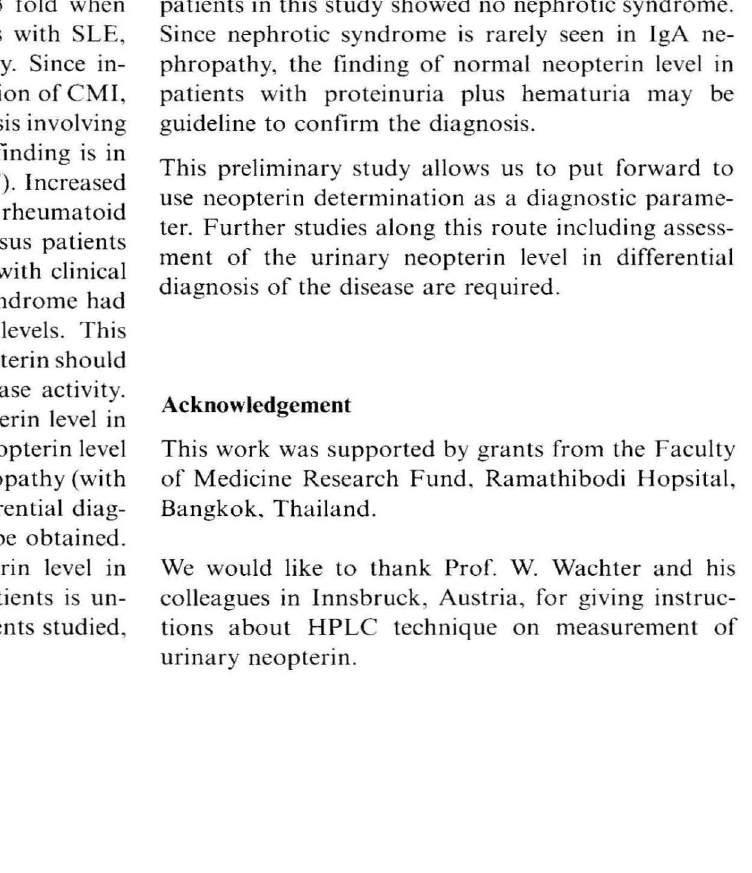
Figure 2. Urinary neopterin in glomerulonephritis patients with proteinuria and nephrotic